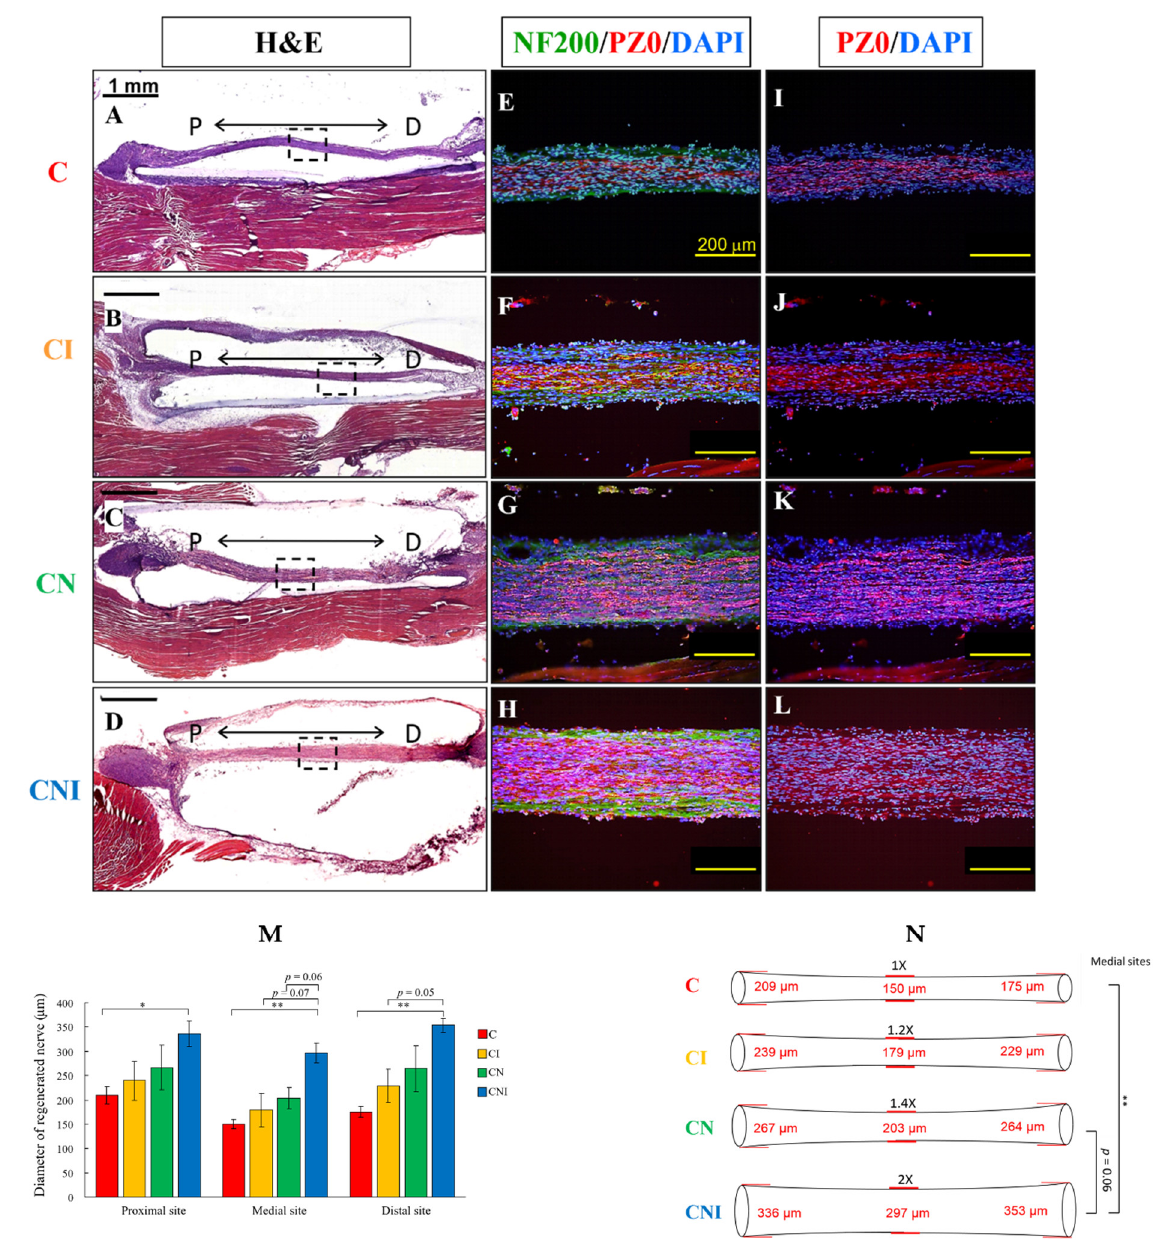
Figure 2. Implantation of PLA conduits with NSCs and human IL12p80 promoted nerve regeneration in the sciatic nerve injury FVB mouse model. ( A – D ) Hematoxylin and eosin (H&E) staining of tissue sections was carried out for the measurements of diameters in sciatic nerve regeneration. “P” and “D” represent the proximal and distal sites of the residual sciatic nerves (“P” is 1.0 mm from the proximal end of the conduit and “D” is 3.0 mm from “P”). ( E – L ) Immunohistochemistry staining with antibody of NF200 (nerve fibers, green), PZ0 (myelin Schwann cells, red), and DAPI (nucleus, blue). For highlighting the myelin sheath cells without NF200 staining, each panel I-L corresponded to E–H, respectively. ( M ) The quantitative results of regenerated nerve diameters at proximal, medial, and distal sites. The medial sites were defined as the middle between the proximal and distal sites (n = 3 in the C and CI groups, n = 4 in the CN group, and n = 5 in the CNI group). ( N ) The illustration of the regenerated sciatic nerves with the different treatment groups. Scale bars in ( A – D ) are 1 mm and ( E – L ) are 200 μm. Statistical differences are indicated by * p < 0.05 and ** p < 0.01.